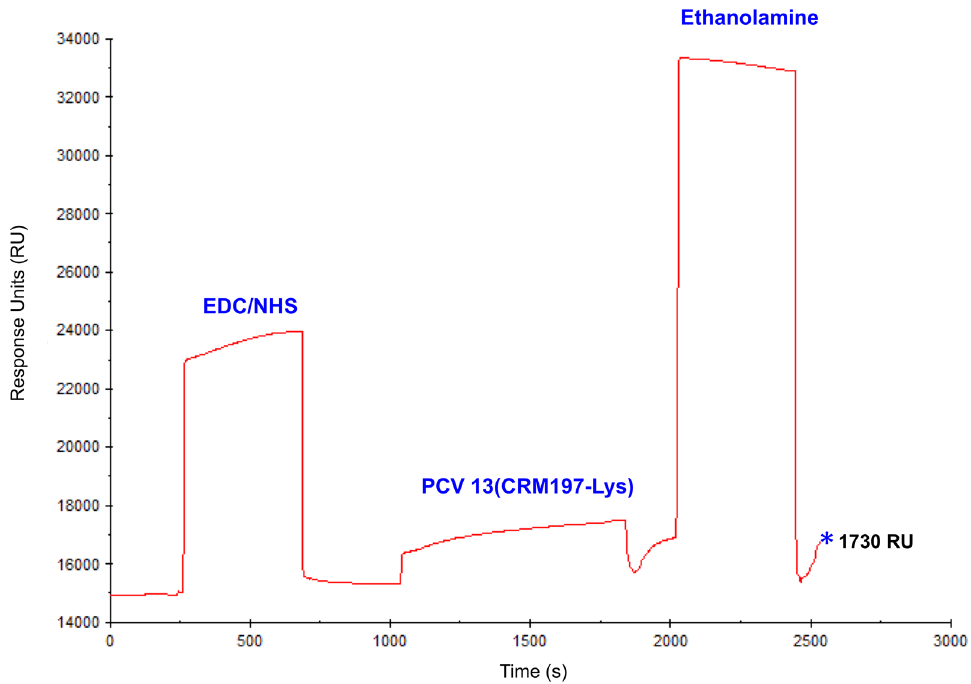
Figure 2. PCV13 immobilization using amine chemistry. Representative SPR sensorgram illustrating the steps of the immobilization process: (1) EDC/NHS were injected to activate the surface of the CM5 chip by modification of the carboxymethyl groups to N-Hydroxysuccinimide esters; (2) Diluted PCV13 was injected and immobilized in the chip surface by spontaneous reaction of the N-Hydroxysuccinimide esters in the chip surface with the amine groups of lysine residues present in PCV13 ′ s diphtheria CRM197 protein; (3) Ethanolamine was injected to block free activated carboxymethyl groups in the chip surface, preventing further unspecific bindings during the SPR experiments. Blue asterisk indicates total immobilization level obtained in the chip (1730